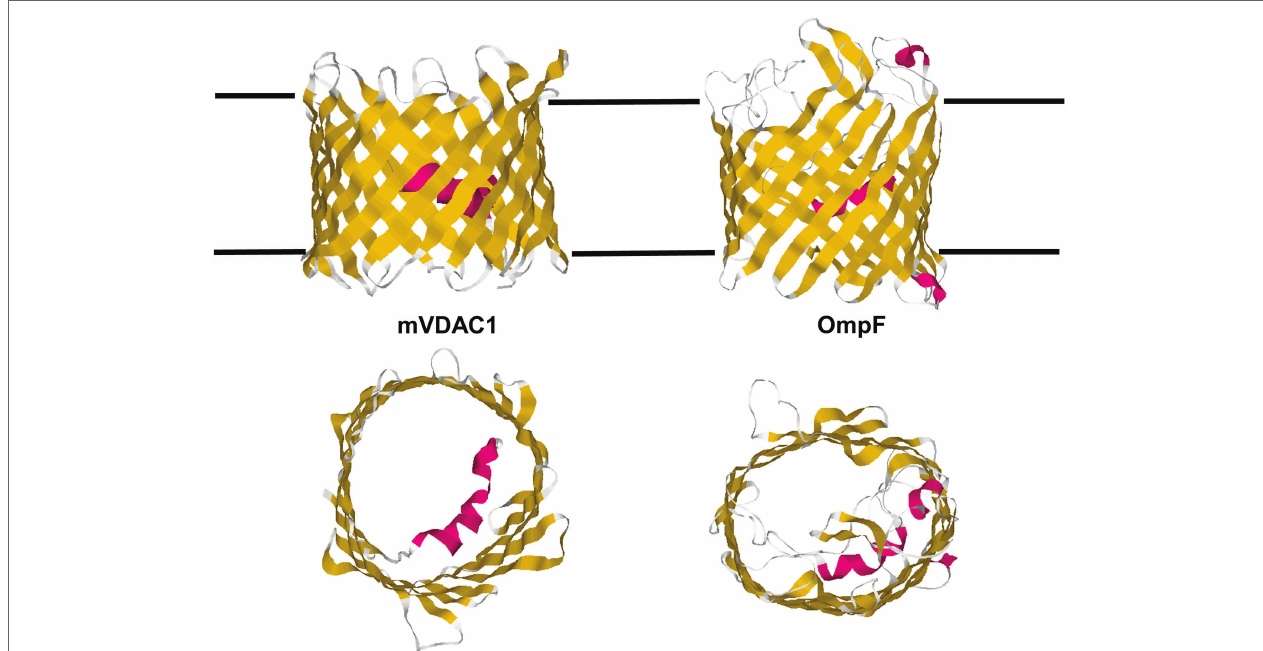
FIGURE 6 | Structure of the mitochondrial outer membrane pore (mVDAC1) and an OmpF monomer of E. coli . β -strands within the protein structures are shown in yellow and α -helical stretches in red. The 3D structures of the proteins are shown from the side in direction to the surface of the mitochondrion and the cell (upper structures) and from the surface of the mitochondrion and the bacterial cell (structures down). mVDAC1 (PDB code: 2JK4) is the 3D structure of mouse mitochondrial porin (Ujwal et al., 2008). OmpF (PDB code: 2OMF) represents the structure of the major outer membrane protein of E. coli (Cowan et al.,